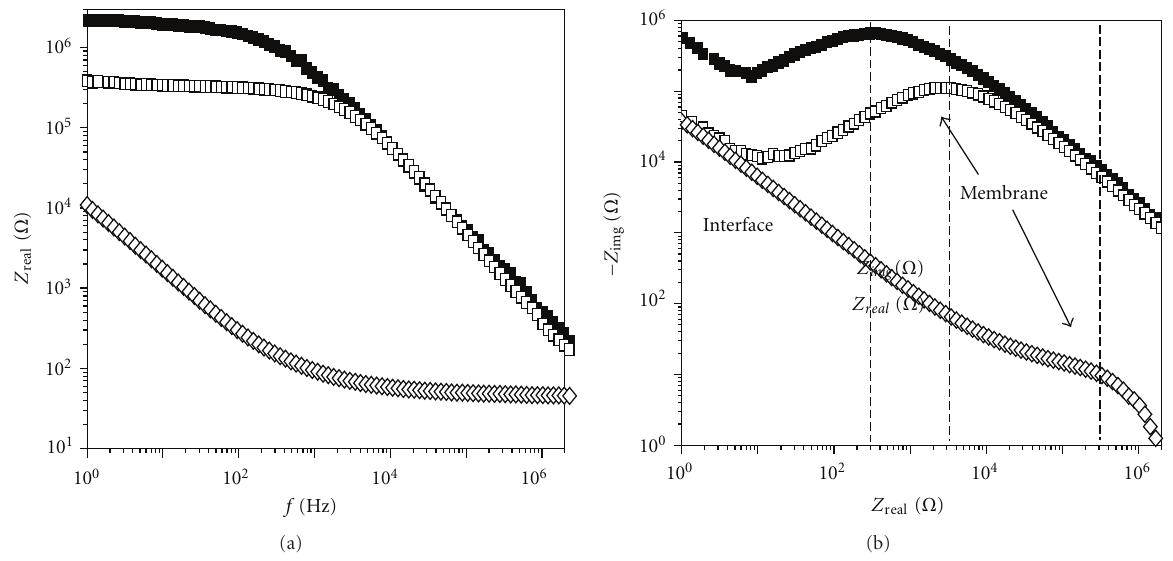
Figure 7: Bode plots, (a) Z real versus frequency and (b) Z img versus frequency, for Nafion-112 ( ♦ ), Naf-112/DTA + dry ( (cid:4) ) and Naf-112/ DTA + (w) ( (cid:5) ) membranes.